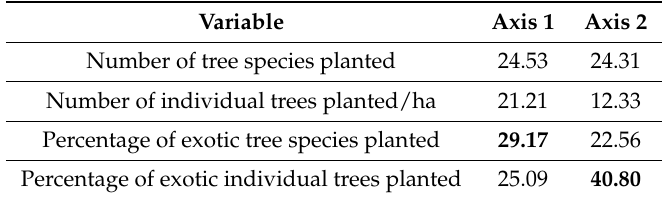
Table 3. Contribution of the four variables used to characterize farmers’ tree planting practices to axis 1 and 2 of the Multiple Correspondence Analysis. Figures in bold have the highest